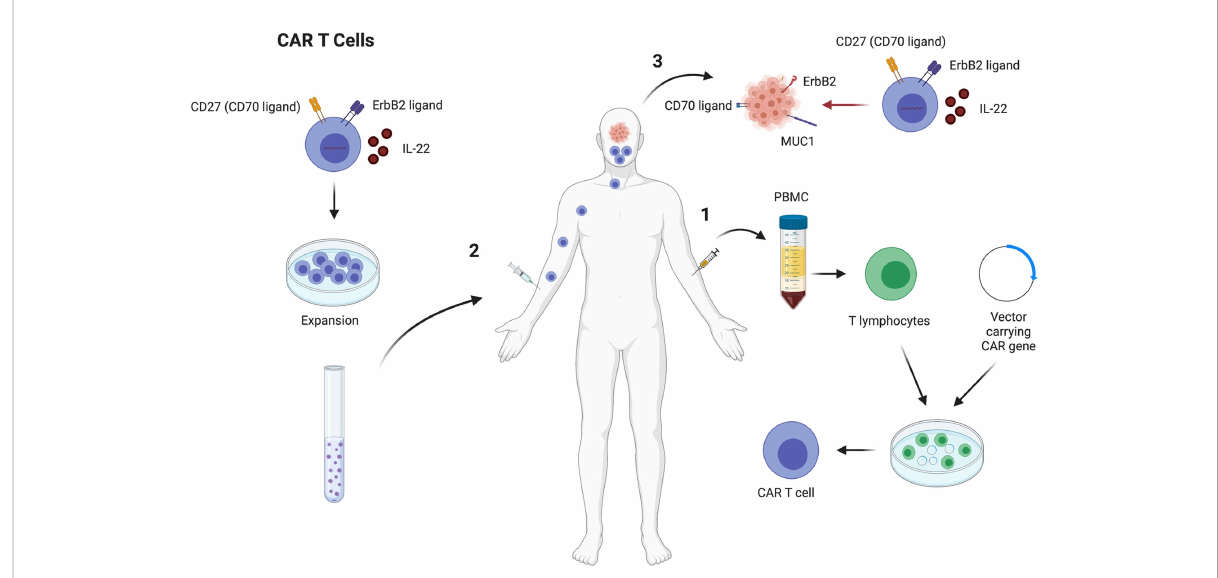
FIGURE 4 CAR T cell therapy to treat HNSCC that express high levels of CD27, ErbB2 and secrete IL22. CAR T cells generation starts by drawing blood from HNSCC patients, followed by PBMC separation. Thereafter, T cells are put in culture in the presence of a vector to induce the cells to express molecules that can target the tumor cells, such as CD27, ErbB2 and IL22 (1). Chimeric antigen receptor T cells are expanded in vitro and injected back in the HNSCC patient that previously provided the T cells (2). The CAR T cells will target the tumor cells through secretion of IL22 that increases the MUC1 expression on the tumors and increase T cell function, and the interactions between CD27/CD70 and ErbB2/ErbB2 ligand, which drives the T cells to the tumor environment (3). Figure generated using Biorender